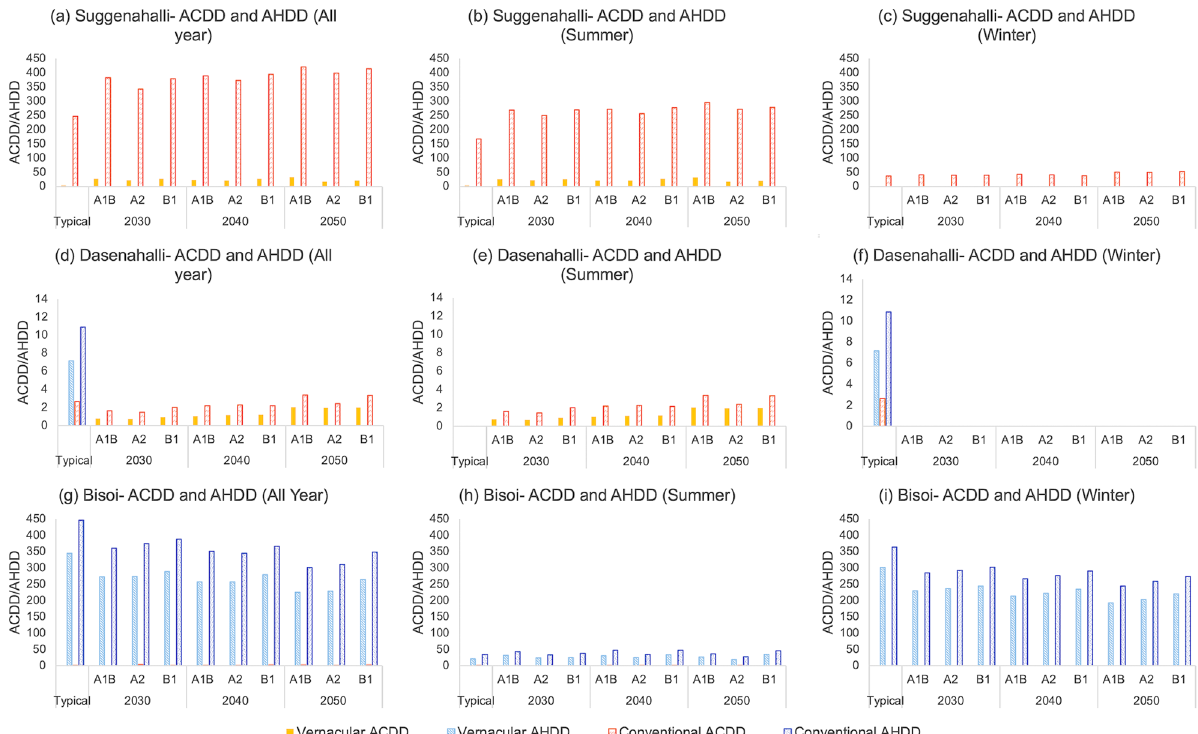
Figure 9. All year, summer and winter AHDD and ACDD for the dwellings in the three villages for typical and future climate scenarios: Each plot depicts the Adaptive heating degree days (AHDD) and Adaptive cooling degree days (ACDD) calculated for vernacular and conventional dwelling for typical scenario and future years 2030, 2040 and 2050 for A1B, A2 and B1 scenarios. Plots from left to right shows typical and future ACDD and AHDD calculated for the entire year, for summer and winter for each rural settlement for both vernacular and conventional dwelling. From ( a ), ( b ) and ( c ) conventional dwelling in Suggenahalli tend to demand active cooling for most part of the year compared to vernacular dwelling. In case of Dasenahalli ( d ), ( e ) and ( f ), it can be seen that demand for heating or cooling is fairly low, cooling demand is slightly higher in conventional dwelling. From ( g ), ( h ) and ( i ), heating demand is high in both dwellings in Bisoi, especially in winter, with heating demand higher in conventional dwelling than vernacular